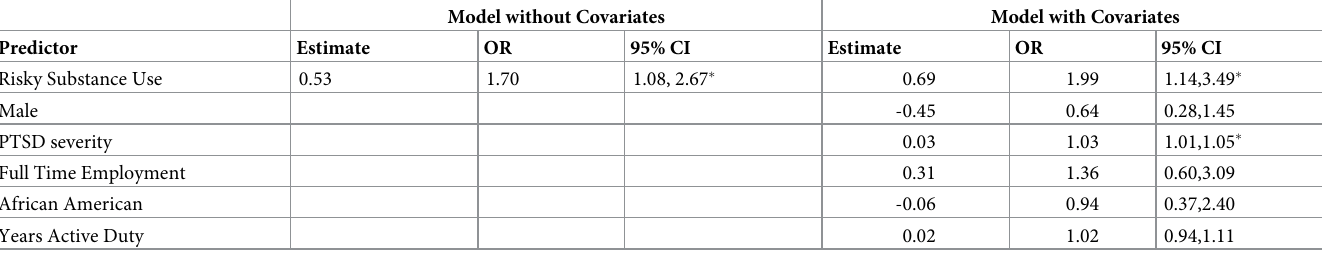
Table 2. Binomial logistic regression models of any compensation award.